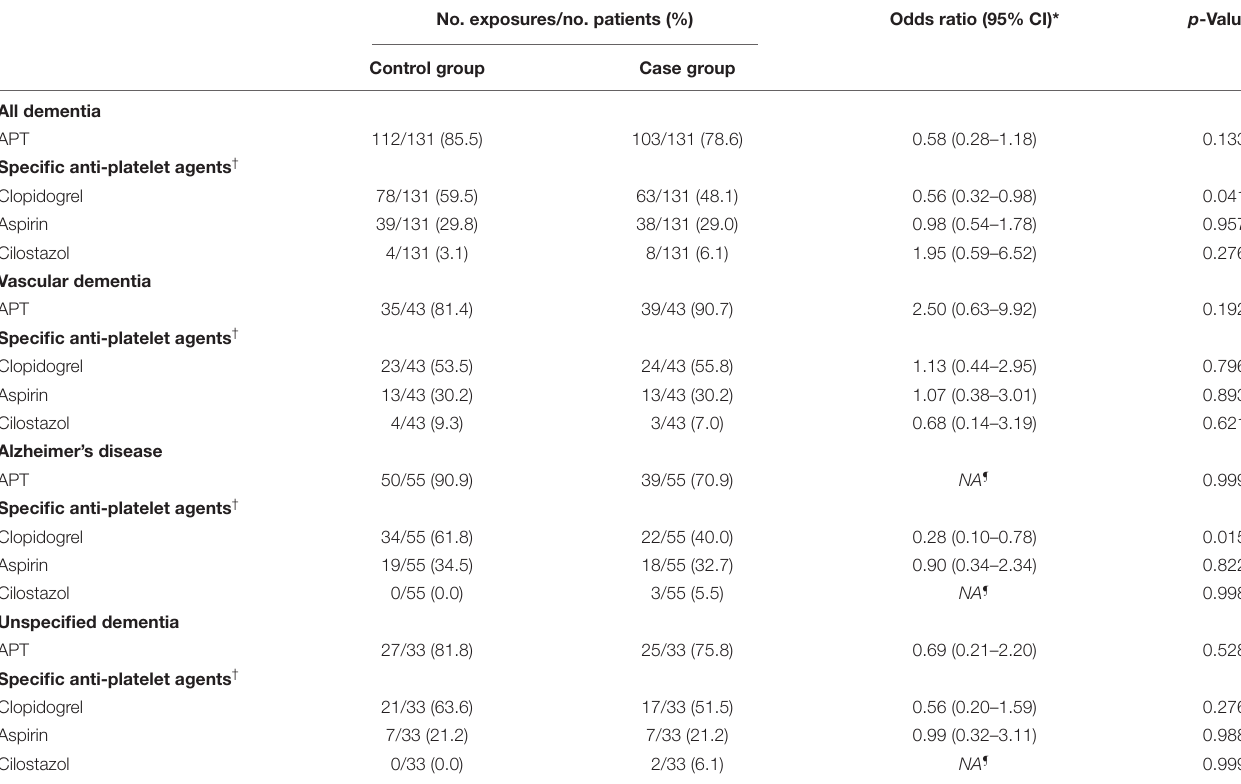
TABLE 3 | The crude analyses of the association between the anti-platelet therapy and dementia, adjusting only for matched covariates (sex and age). No. exposures/no. patients